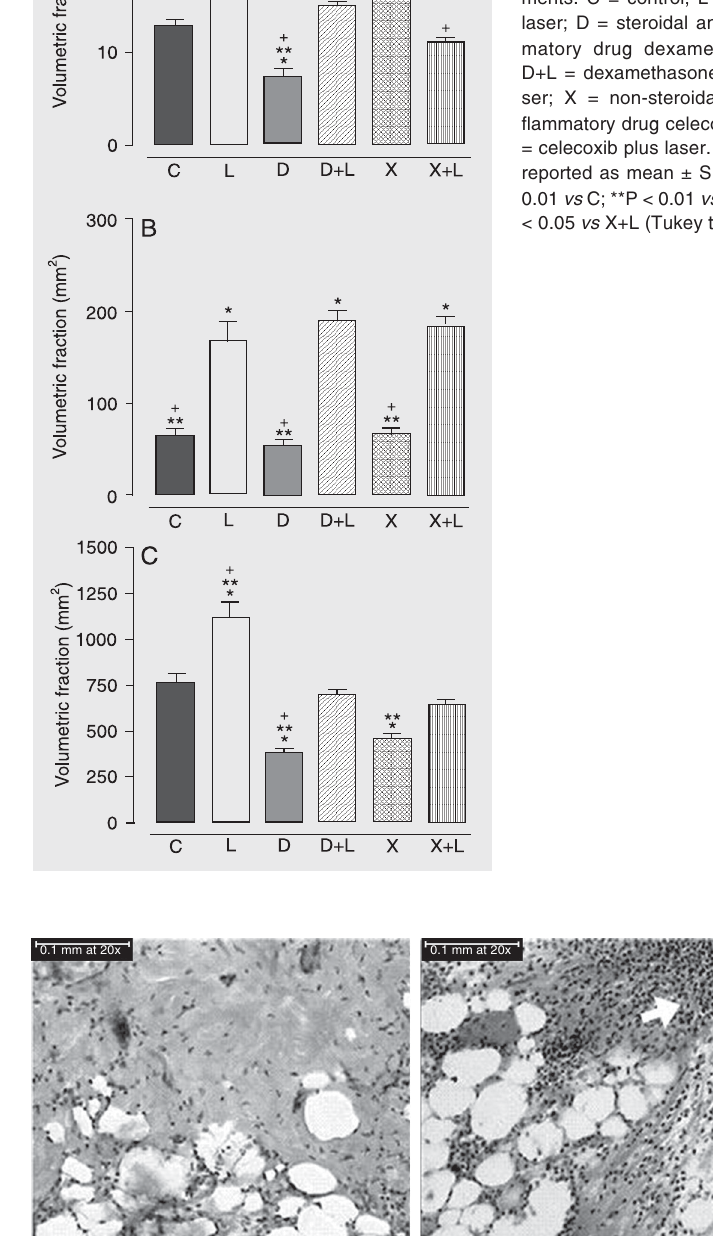
Figure 2. Determinations of the volumetric fractions of the epi- thelium (A), collagen (B), and cellularity (C; neutrophils and fibroblasts/myofibroblasts) of mouse skin 24 h after treat- ments. C = control; L = He-Ne laser; D = steroidal anti-inflam- matory drug dexamethasone; D+L = dexamethasone plus la- ser; X = non-steroidal anti-in- flammatory drug celecoxib; X+L = celecoxib plus laser. Data are reported as mean ± SEM. *P < 0.01 vs C; **P < 0.01 vs D+L; + P < 0.05 vs X+L (Tukey test).